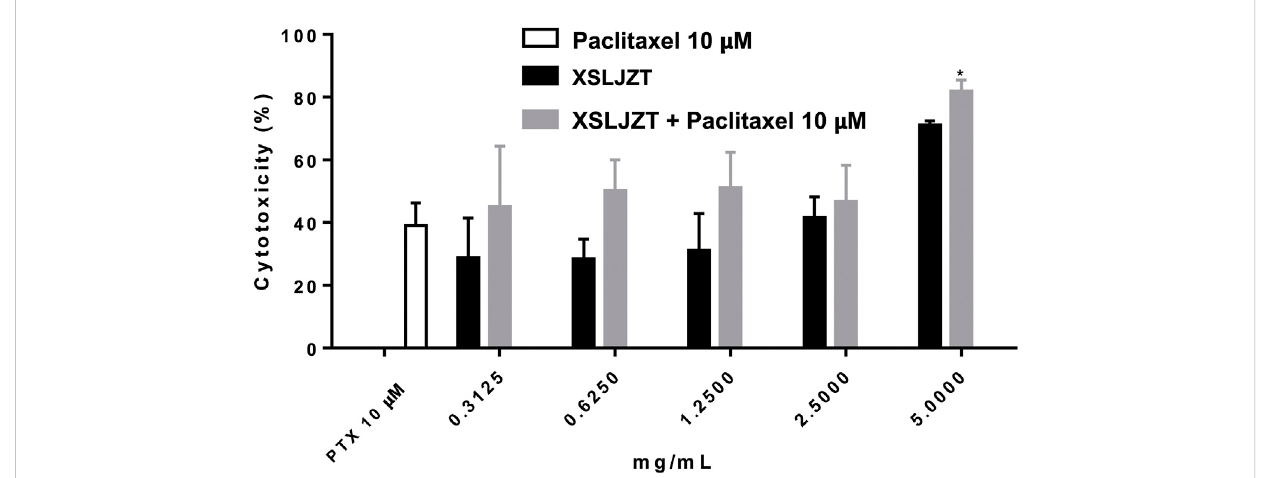
FIGURE 2 Cytotoxic effects of paclitaxel XSLJZT and XSLJZT combined with paclitaxel on P388-D1 cells. Paclitaxel signi fi cantly inhibited the growth of P388- D1 cells at 10 µM. 5 mg/mL of XSLJZT combined with paclitaxel was signi fi cantly better than paclitaxel *: p < 0.05, n = 3.